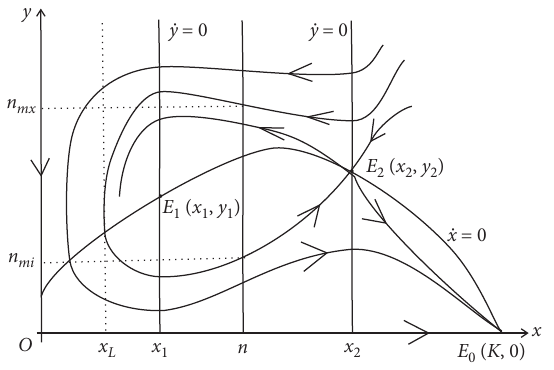
Figure 1: Phase portrait of system (1) if conditions in Theorems 1 and 2 are